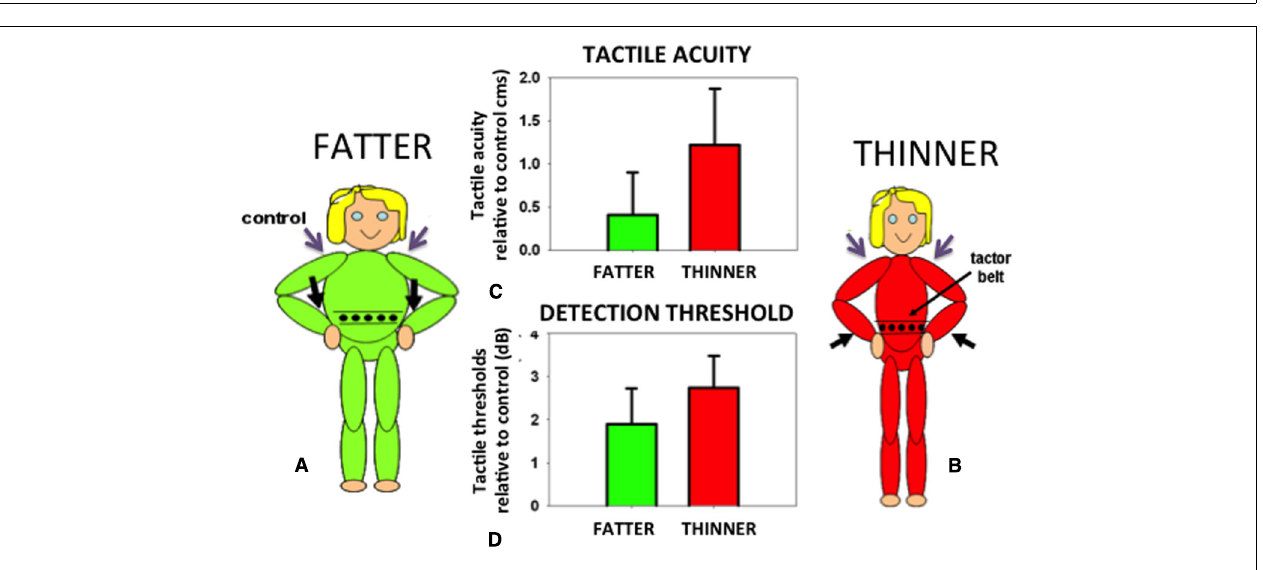
FIGURE 4 | Localizing a touch on the waist. During eccentric gaze both the perceived body midline and the perceived direction of gaze are mis-estimated in the directions of the dashed arrows (see text). Localizing a touch relative to one of these reference directions therefore results in the perceived location of touch moving toward that direction (A) . For a